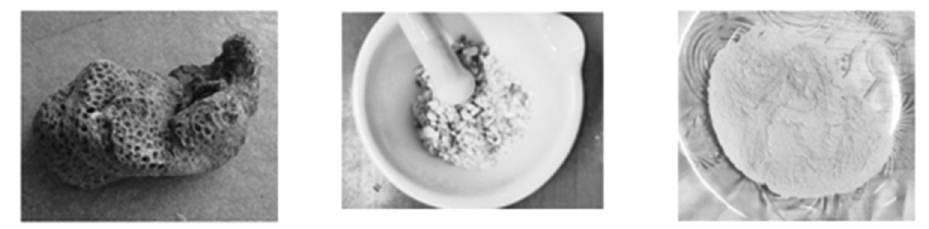
Figure 1: The process of scouring the coral becomes